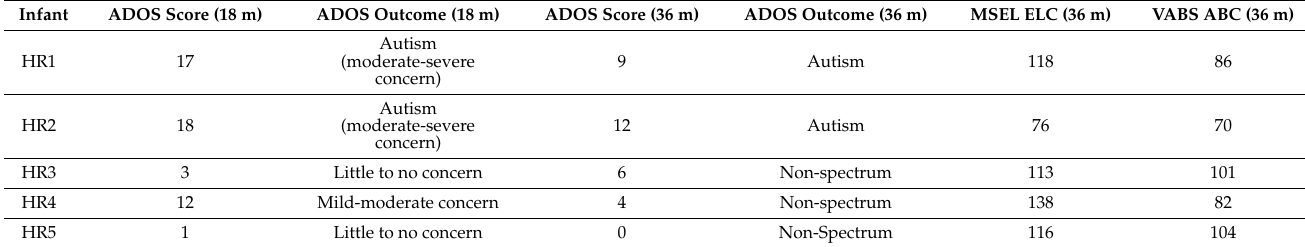
Table 2. Developmental